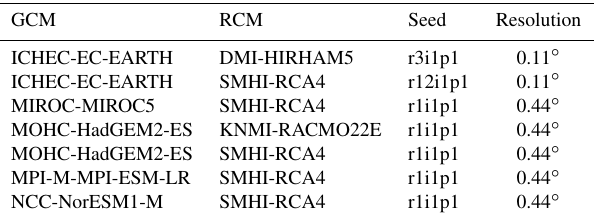
Table 2. Climate change model chains used in this study. For each model chain the RCP2.6, RCP4.5, and RCP8.5 scenarios are